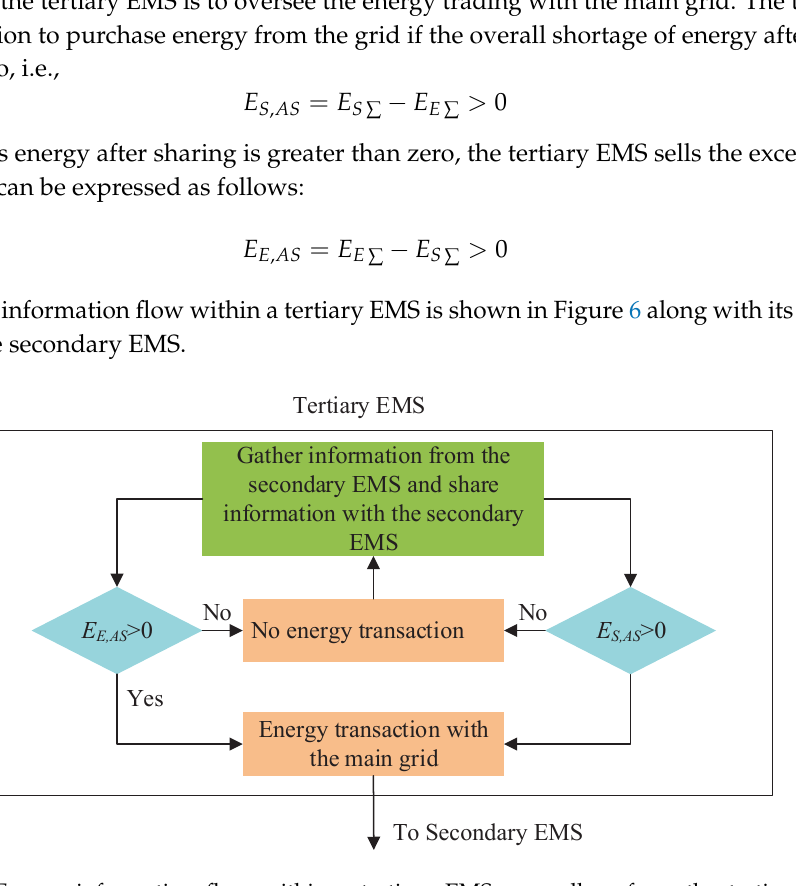
Figure 6. Energy information flow within a tertiary EMS, as well as from the tertiary to the secondary